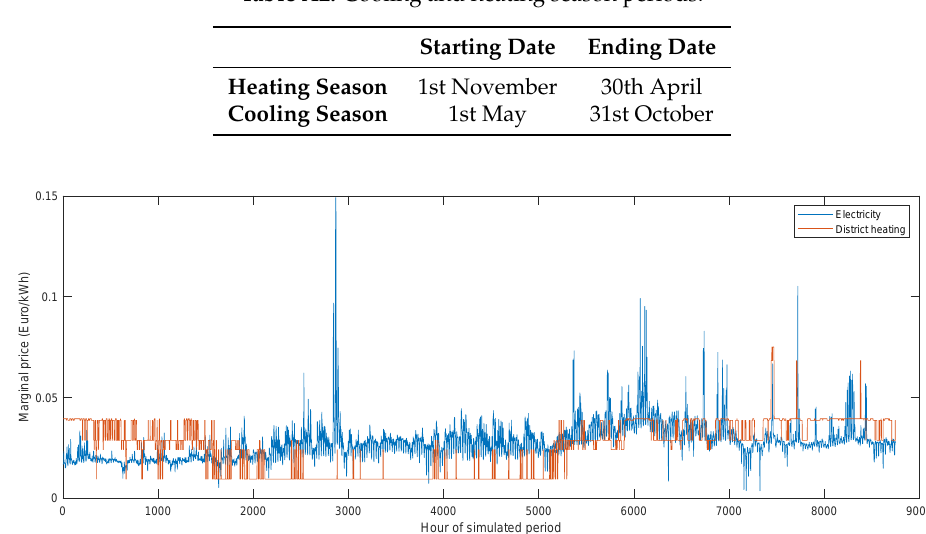
Figure A1. Marginal prices from external electricity and district heating networks over the simulated